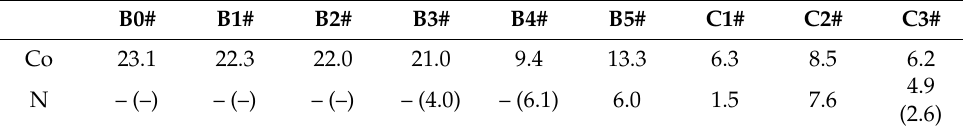
Table 2. Co and N content obtained from the surface and particles of the different specimens.